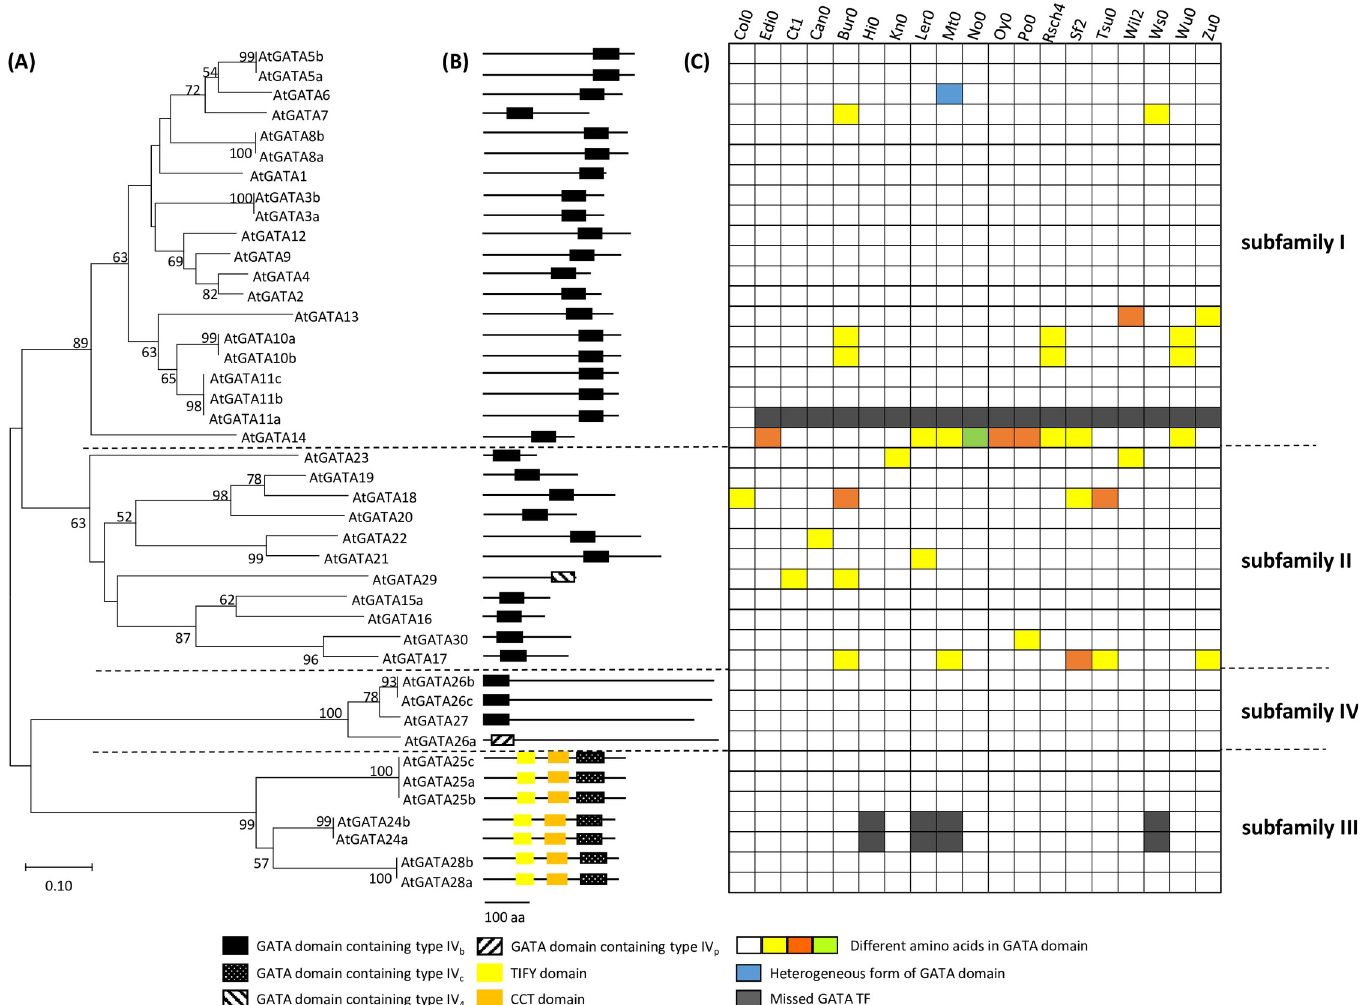
Fig 4. Domain structure in A . thaliana Col0 and amino acid varaitions of GATA TFs of 19 A . thaliana . (A) is the phylogenetic analysis of A . thaliana Col0 GATA domains. This is made of a neighbor-joining tree of GATA domain amino acid sequences from A . thaliana Col0 GATA TFs. Bootstrap values calculated from 10,000 replicates are shown on the tree except that those values are lower than 50. The scale bar corresponds to 0.10 estimated amino acid substitutions per site. (B) is protein domain organization of the corresponding GATA TFs. Black boxes with four different patterns indicate GATA domains with four different types. Type IV b , IV c , IV 4 , and IV p mean CX 2 CX 18 CX 2 C, CX 2 CX 20 CX 2 C, CX 4 CX 18 CX 2 C, and partial forms, respectively. Yellow- and orange-colored boxes indicate functional domains of TIFY and CCT, respectively. Subfamily names were displayed at the right side. Definitions of each box were presented in the right-top side. (C) shows GATA domain sequence types along with each GATA TF and A . thaliana genome. The X-axis of the matrix presents ecotypes of A . thaliana and Y-axis means each GATA TFs. Four different colors, white, yellow, orange, and green, indicate different amino acids in each Arabidopsis GATA TFs and the blue color presents heterogeneous amino acid in a specific position caused by heterogeneous nucleotide. Dark grey color means missed GATA TFs along with 19 ecotypes.